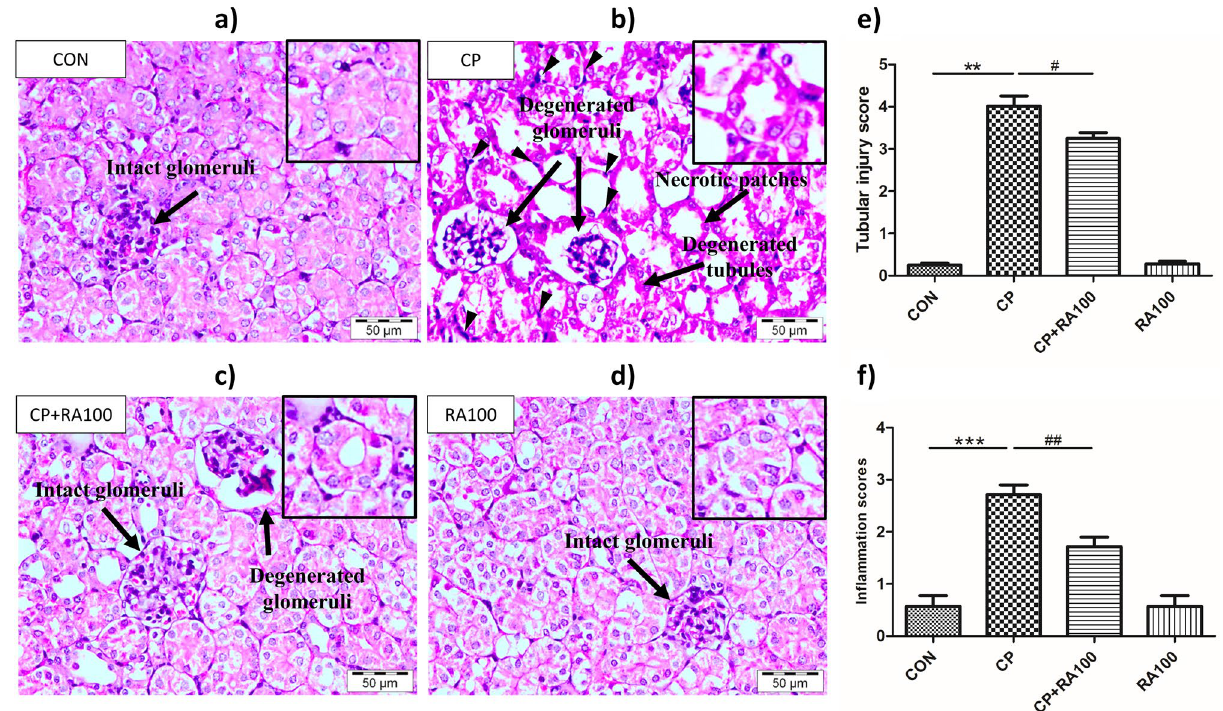
Figure 1. Effect of RA on kidney histological morphology changes in various groups of animals. In ( a ), kidney section of control group animal treated with normal saline shows normal histoarchitecture with smooth and homogenous cellular structure. Normal glomeruli are represented by a black arrow. In ( b ), kidney section of CP-treated mouse shows altered histology with necrotic changes, degenerated glomeruli and tubular damage represented by the black arrows. In ( c ), kidney section of mouse treated with RA along with CP depicts a significant restoration in histology. However, some degenerated glomeruli still persisted with intact and normal glomeruli. ( d ) RA alone treatment showed no adverse changes in histology of mouse kidney section. In ( e ), histogram represents significant changes after CP and RA administration in mouse kidney sections and ( f ) histogram represents the inflammation scores. Treatment of CP caused a significant increase in histological changes ( **p < 0.01) and significant infiltration of inflammatory cells ( * * *p < 0.001) when compared with the control group of animals. Treatment of RA attenuated the CP-induced tubular injury and inflammation in a significant manner ( # p < 0.05) and ( ## p < 0.01), respectively in CP + RA group when compared with the CP-treated group. Scale bars: 50 μm; original magnification: ×